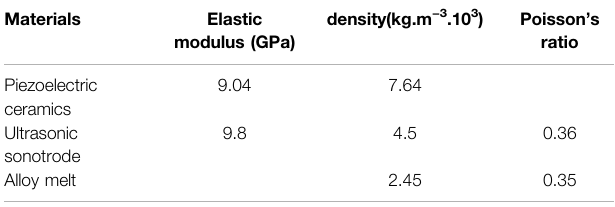
TABLE 1 | Key parameters in the simulation model (Tian et al., 2018).